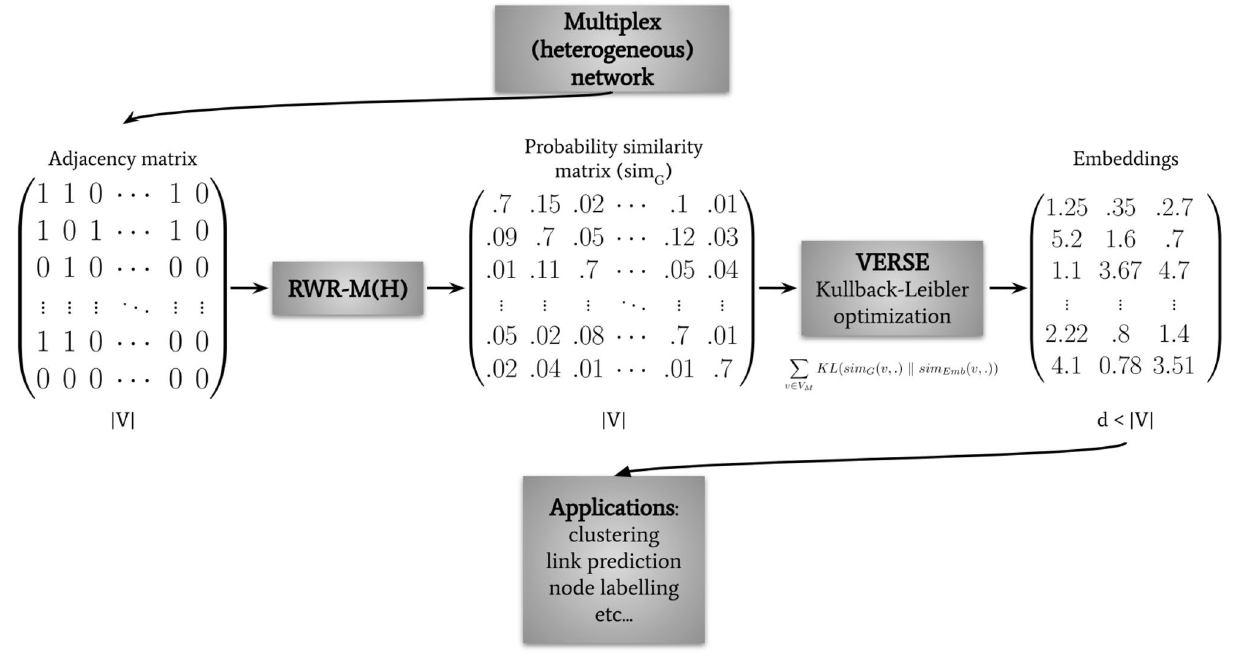
Figure 2. Overview of the MultiVERSE pipeline. Starting from a multiplex-heterogeneous network, we represent its structure through an adjacency matrix (size | V | × | V | ); we then compute a similarity matrix using Random Walk with Restart algorithm, and apply an optimized version of the VERSE algorithm to compute the embeddings. The resulting matrix of embeddings will be used for the